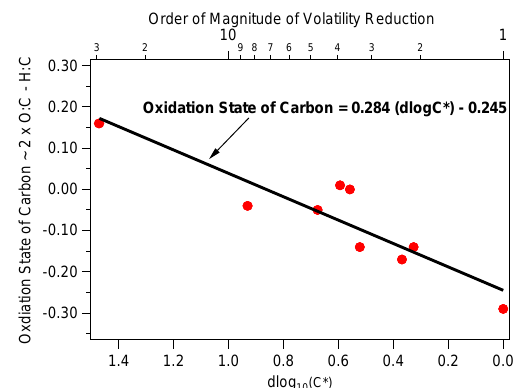
Figure 8. Oxidation state and volatility reduction in terms of change of log C ∗ for the toluene SOA system. Red circles represent a single experiment and a single best-fit (black) line shows the